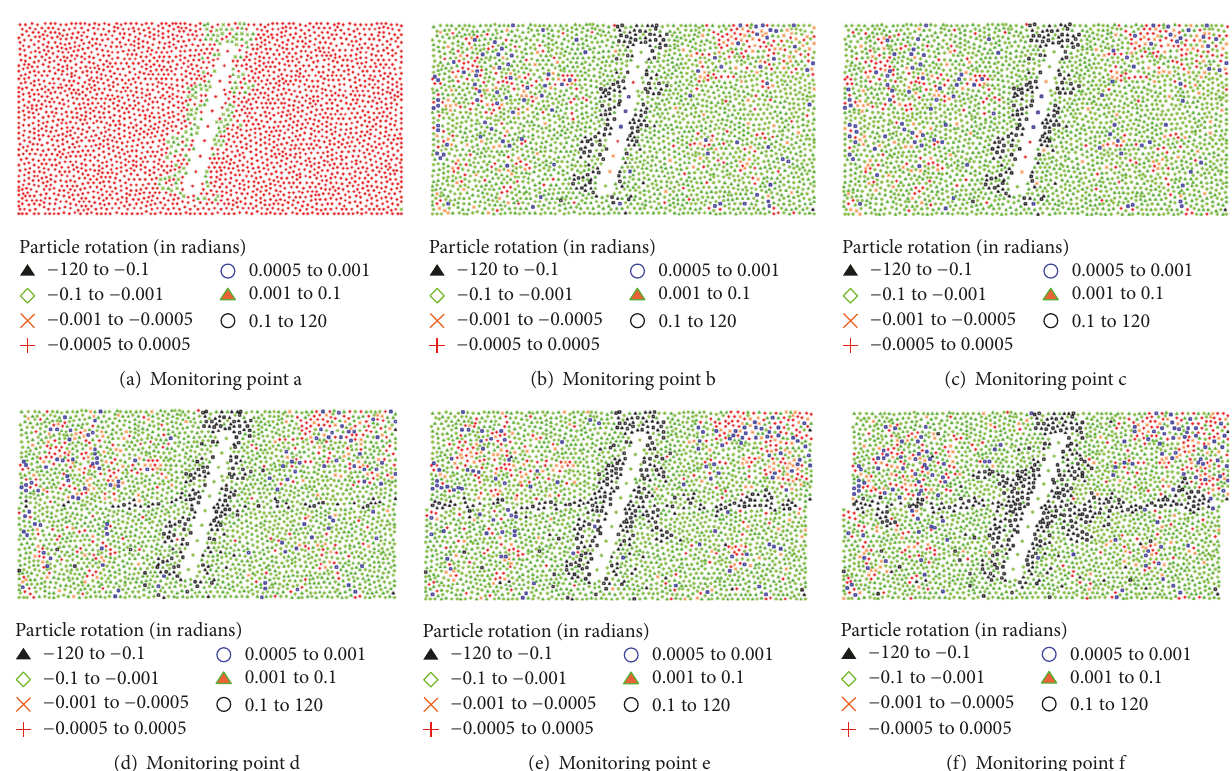
Figure 15: Evolution of disk rotation in radians in the specimen at different monitoring points.